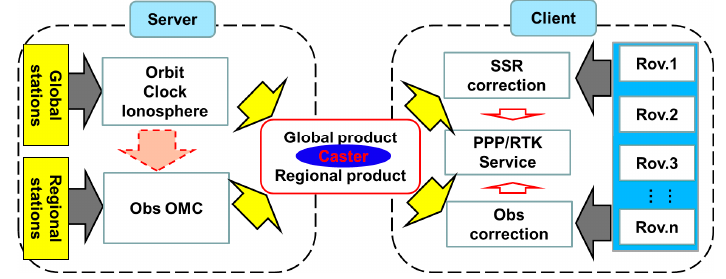
Figure 1. The processing flow of integrated PPP/RTK algorithm (“Rov.” represents the rover stations, “Obs” represents the observation domain, “SSR” denotes the state space represents, “OMC” is the observed minus the computed corrections, “Caster” is used to receive and broadcast the global and the regional products).